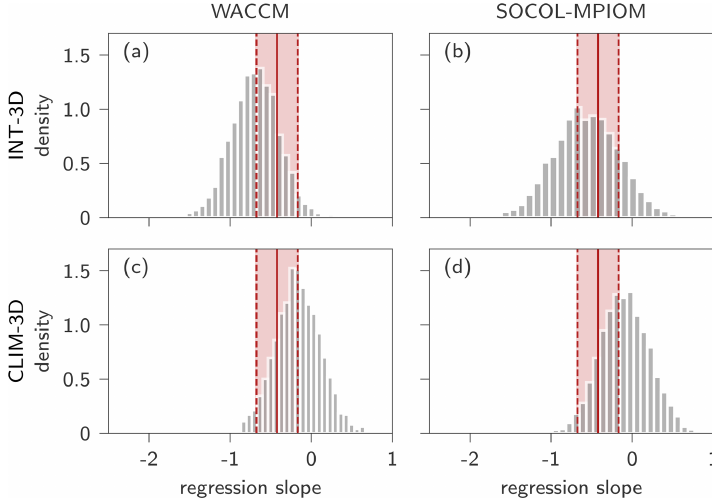
Figure A3. Regression slopes in model simulations and reanalysis. Regression slope of the maximum 5d running mean partial ozone column (30–70hPa) on the FSW date following Fig. 3 for 5000 samples consisting of 40 randomly selected years each for both sets of model simulations. The regression slope of the reanalysis is shown by the solid red line, with its standard error indicated by the red shaded area.